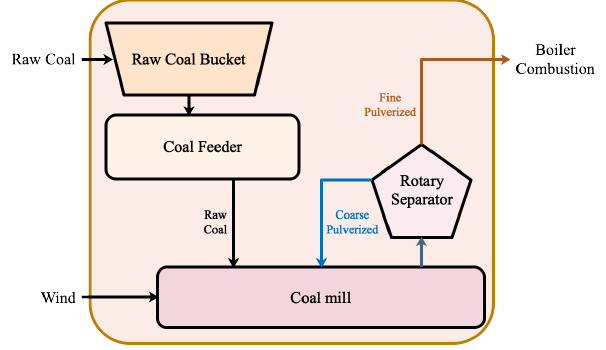
Figure 1. Schematic of a coal pulverizing